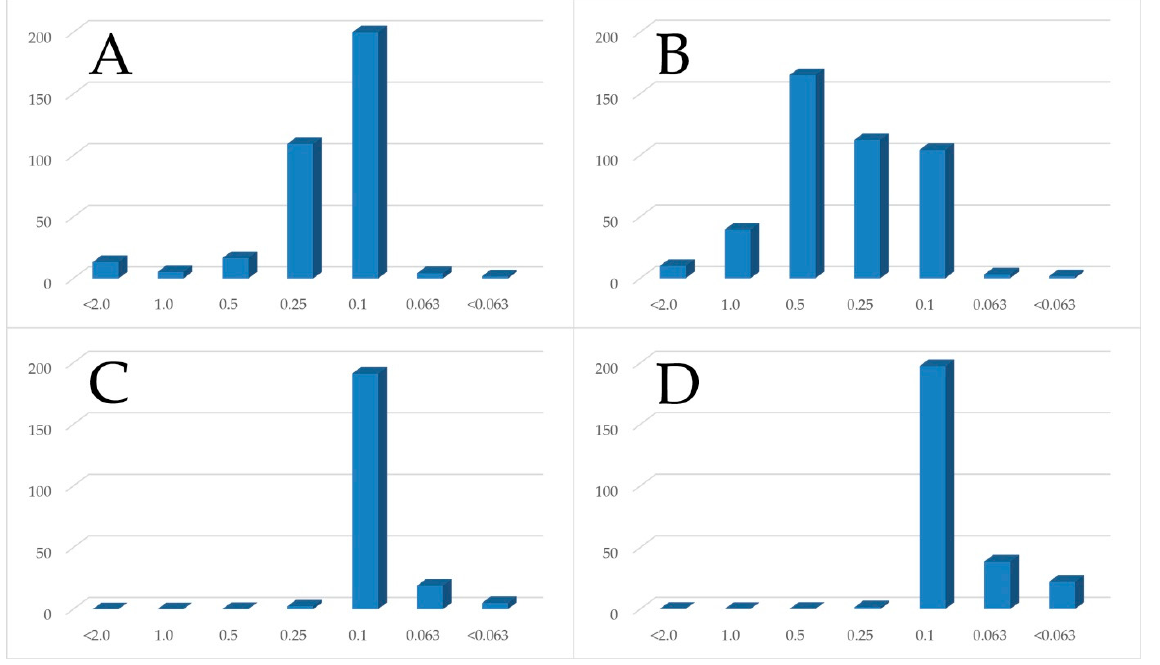
Figure 2. Grain size distribution in tailing samples in mm; ( A ) fine-grained, medium-sorted tailing from Toboali; ( B ) medium-sorted, poorly sorted tailing from Lubuk; ( C ) fine-grained, well-sorted tailing from Pemali; ( D ) fine-grained, medium-sorted tailing from Sungai Liat.